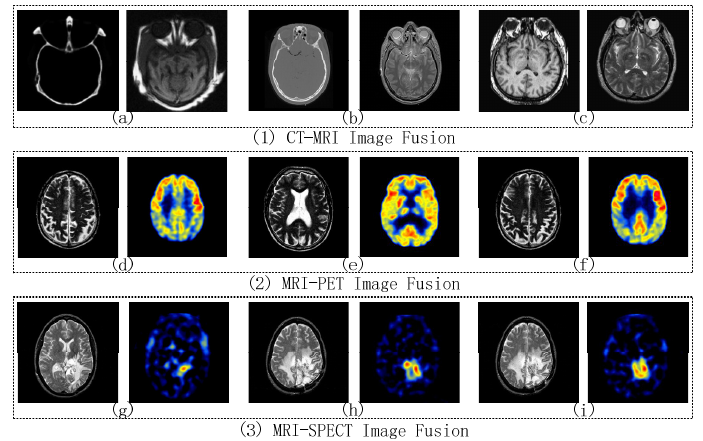
Figure 5. Nine Image Fusion Comparative Experiments, ( a )–( c ) are CT-MRI source image pairs; (d )–( f ) are MRI-PET source image pairs; and ( g )–( i ) are MRI-SPECT source image